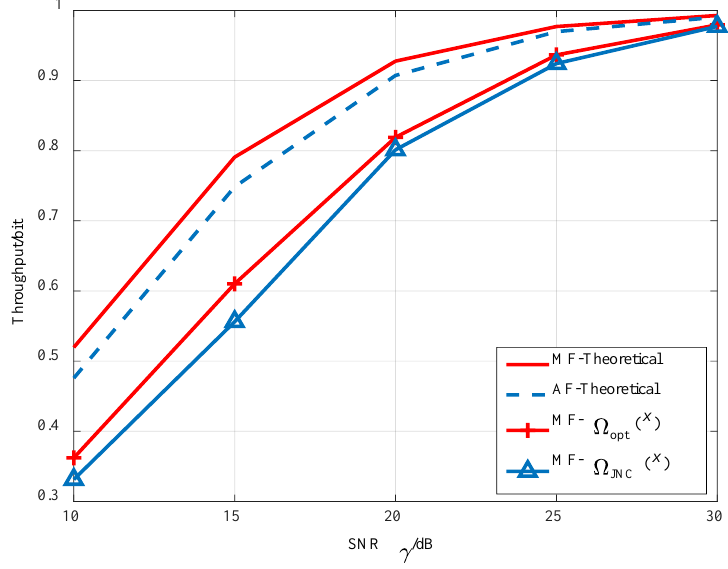
Figure 8. Throughputs of the SLT-coded TWRN system with different degree distributions.